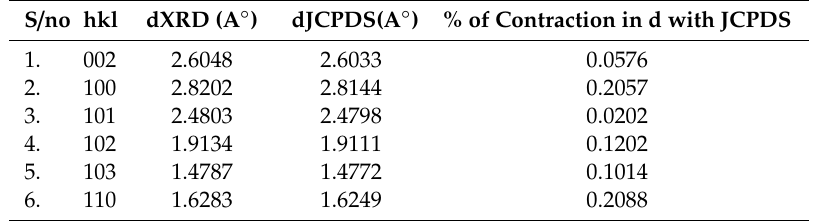
Table 2. Spacing of the planes (dhkl) from XRD, JCPDS data card for equivalent (hkl) planes. S / no hkl dXRD (A ◦ ) dJCPDS(A ◦ ) % of Contraction in d with